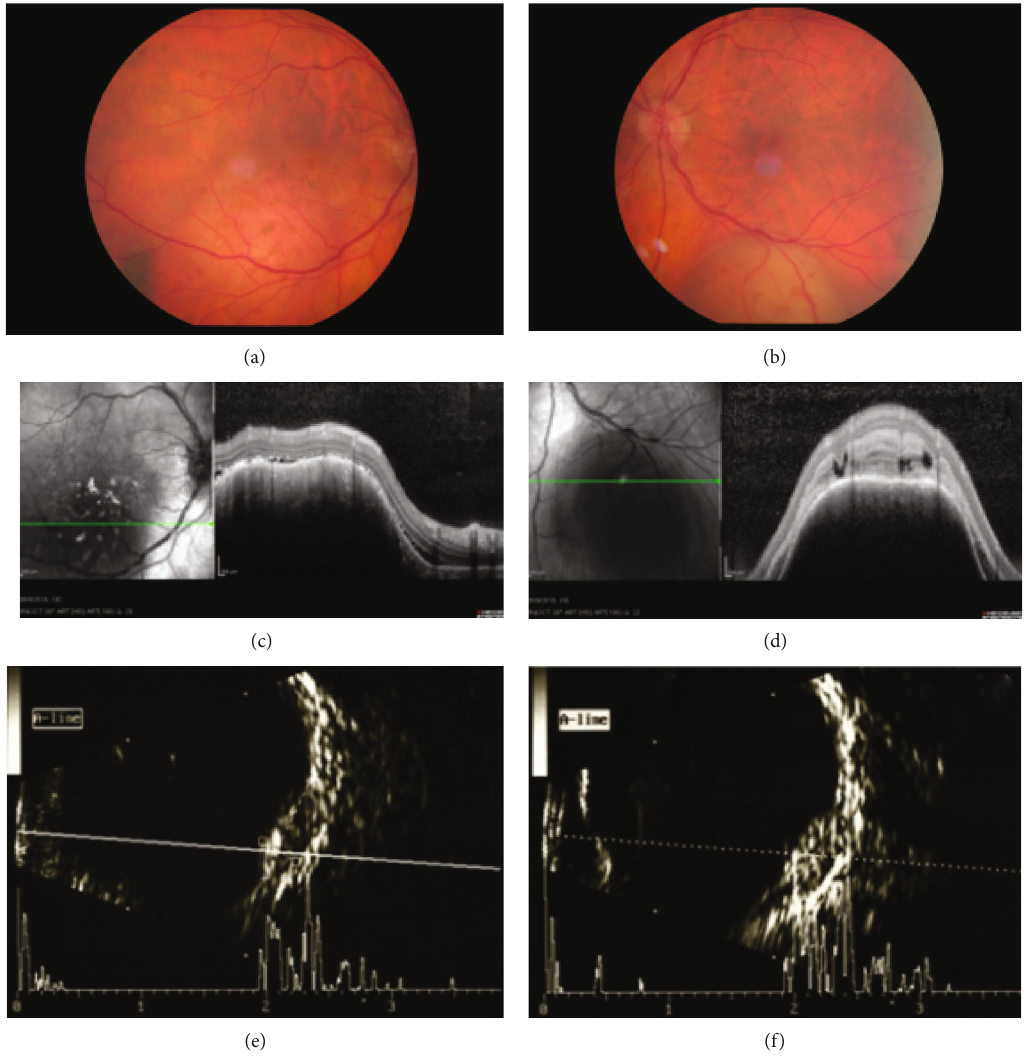
Figure 1: Color fundus image of the right eye (a) revealed an elevated, oval-shaped, lightly pigmented, orange, subretinal lesion in the inferotemporal quadrant with secondary serous retinal detachment extending to the macula. In the left eye (b), a nonpigmented, reddish- white, subretinal lesion below the inferior temporal arcade was observed. Examination with optical coherence tomography in the right eye (c) revealed eradication of the choriocapillaries and irregular choroidal surface overlying the lesion and in the left eye (d) showed a dome- shaped choroidal morphology, compression of the overlying choriocapillaris, and intraretinal fl uid at the site of the lesion. Ultrasound examination showed dome-shaped choroidal lesions in the right (e) and left (f) eyes with a medium-to-high internal re fl ectivity and a dense acoustic